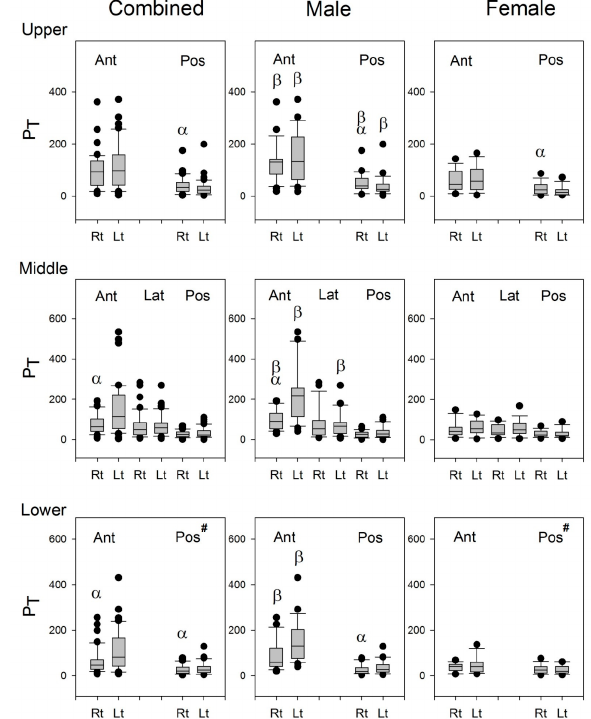
Figure 6. The boxplots of P T in the combined group, male group, and female group. #: Three of the 18 female subjects were excluded from the statistics because of excessive artifacts at this site. α : p < 0.05 between right and left lungs, β : p < 0.05 vs. its counterpart in the female subjects. Ant: anterior; Pos: posterior; Lat: lateral; Rt: right, Lt: left.